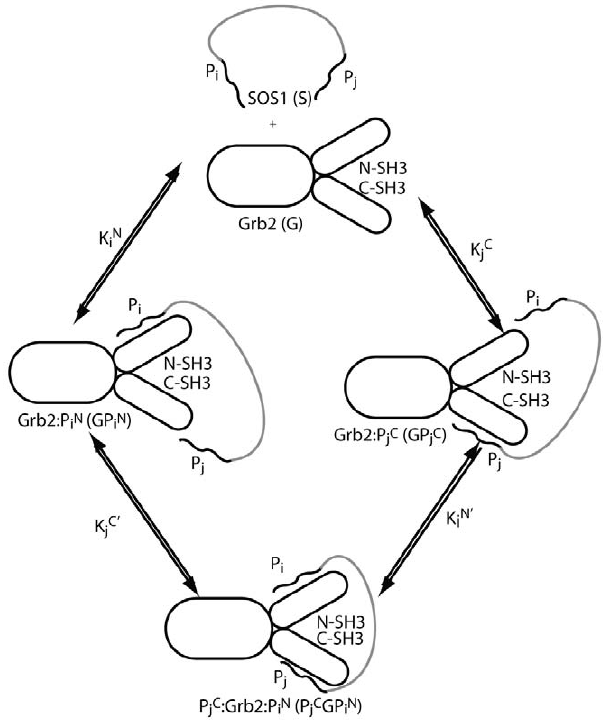
Figure 4. The possible steps in the binding of two polyproline binding sites, P i and P j , on Sos1 to the N-SH3 and C-SH3 domains on Grb2 to form a doubly bound 1:1 complex of Grb2 and Sos1. i , j ~ 1 to 5 , represents the peptides P1 through P4 and RP respectively and i = j .